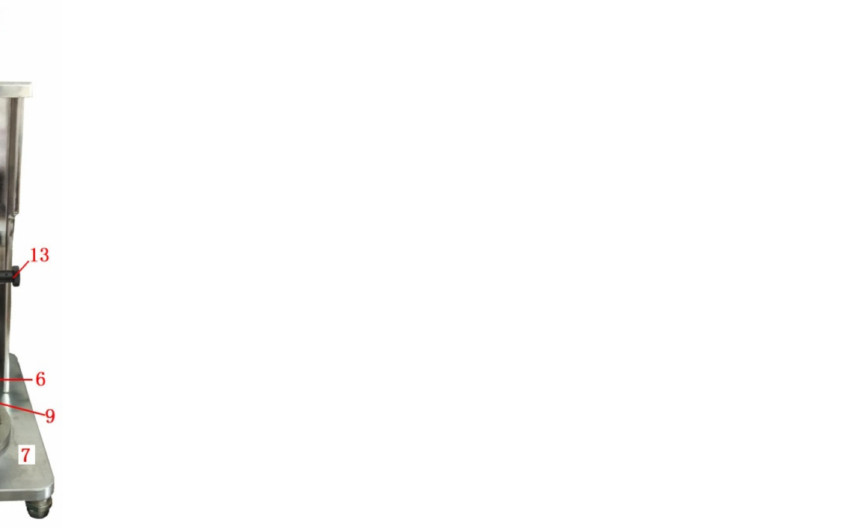
Figure 2. Experimental equipment: 1—lift motor, 2—left-right motor, 3—lift translation table, 4—translation table, 5—sensor, 6—fixture, 7—instrument main table, 8—friction assembly, 9—steel ball fixture, 10—sample, 11—sample fixture, 12—lifting knob, and